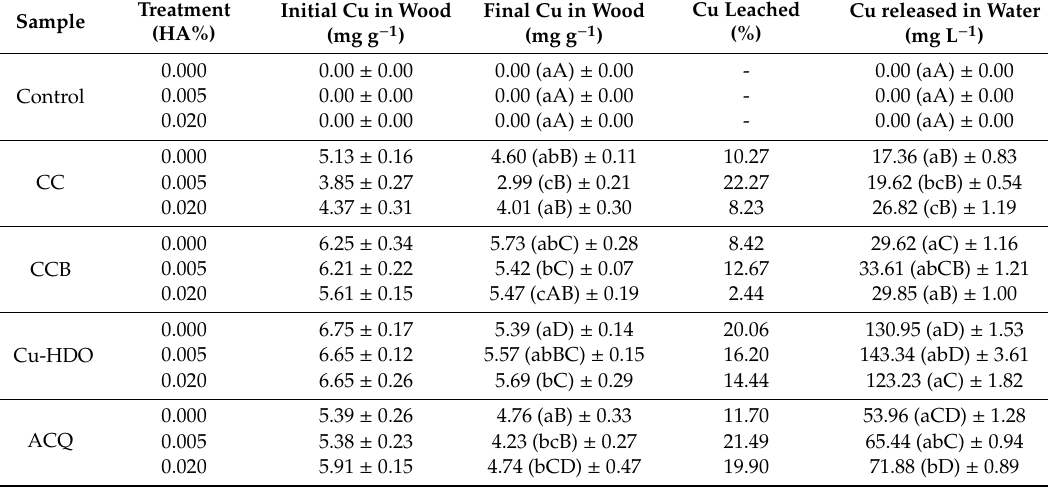
Table 2. E ff ect of humic acid on wood preservative leaching from treated wood specimens.